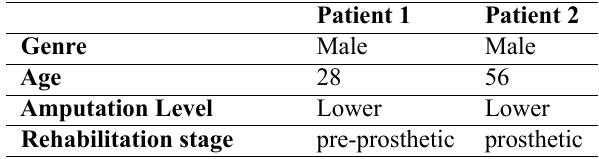
Table 2. Profile of the patients selected for the solution validation.